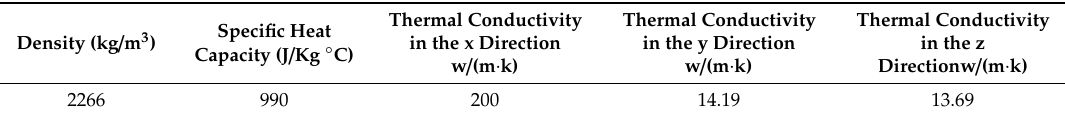
Table 2. Battery physical parameter.